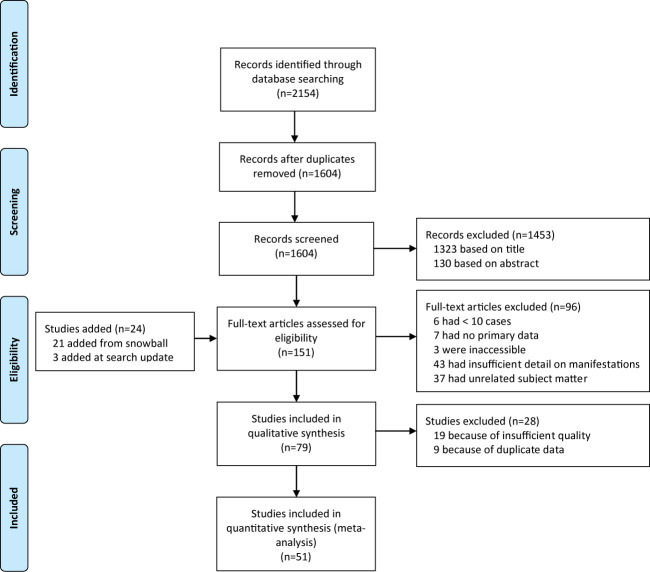
Flow chart showing the study selection process.